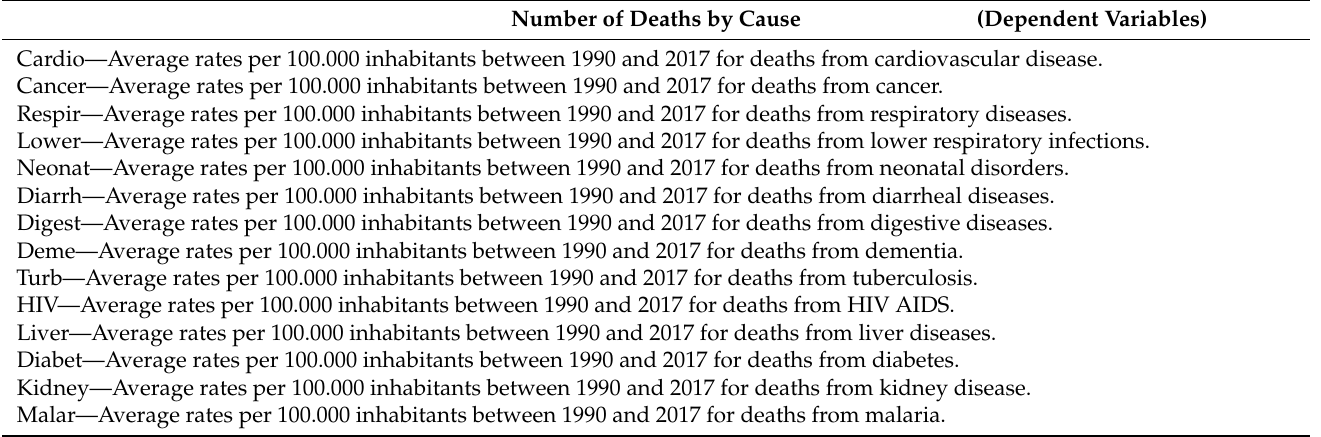
Table 1. Number of deaths by cause in the world (Source: Institute for Health Metrics and Evaluation, IHME). Number of Deaths by Cause (Dependent Variables) Cardio—Average rates per 100.000 inhabitants between 1990 and 2017 for deaths from cardiovascular disease.